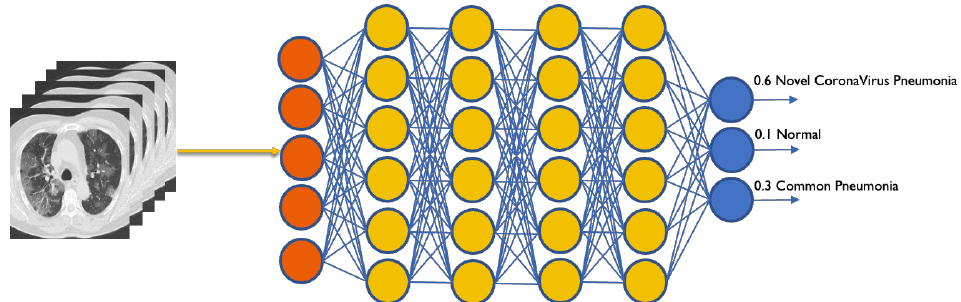
Figure 7. A representation of the classification process for the build models. The model obtains in input a CT scan and produces a distribution probability on the possible classification labels.